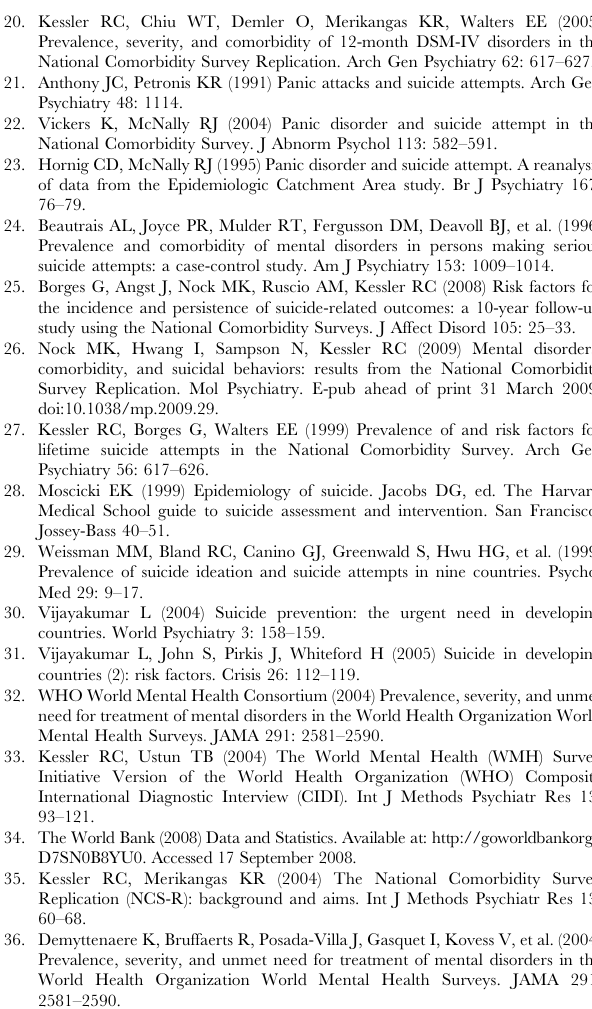
Table S4 Multivariate survival models of interactive associations between type and number of temporally primary lifetime DSM- IV/CIDI disorders in predicting the subsequent first occurrence of suicidal behaviors—developing